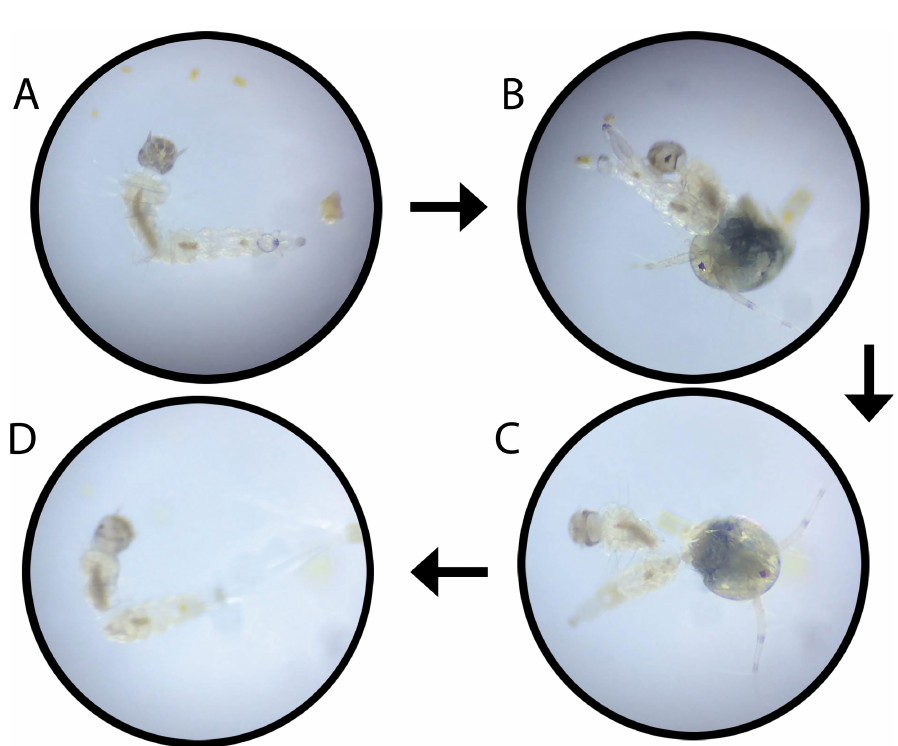
Fig 6. Predation of Aedes larvae by Mesocyclop leuckarti . (A) First instar Aedes larvae. (B) Capturing of Aedes larvae by Mesocyclop leuckarti . (C) Killing of Aedes larvae by Mesocyclop leuckarti . (D) Dead Aedes larvae.